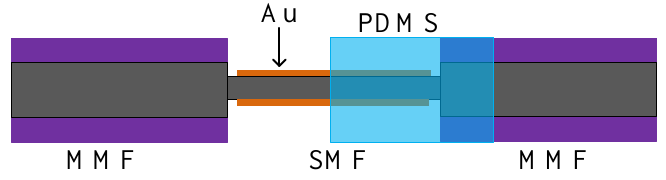
Figure 10. The description of the SPR sensor coated with Au and PDMS [43].